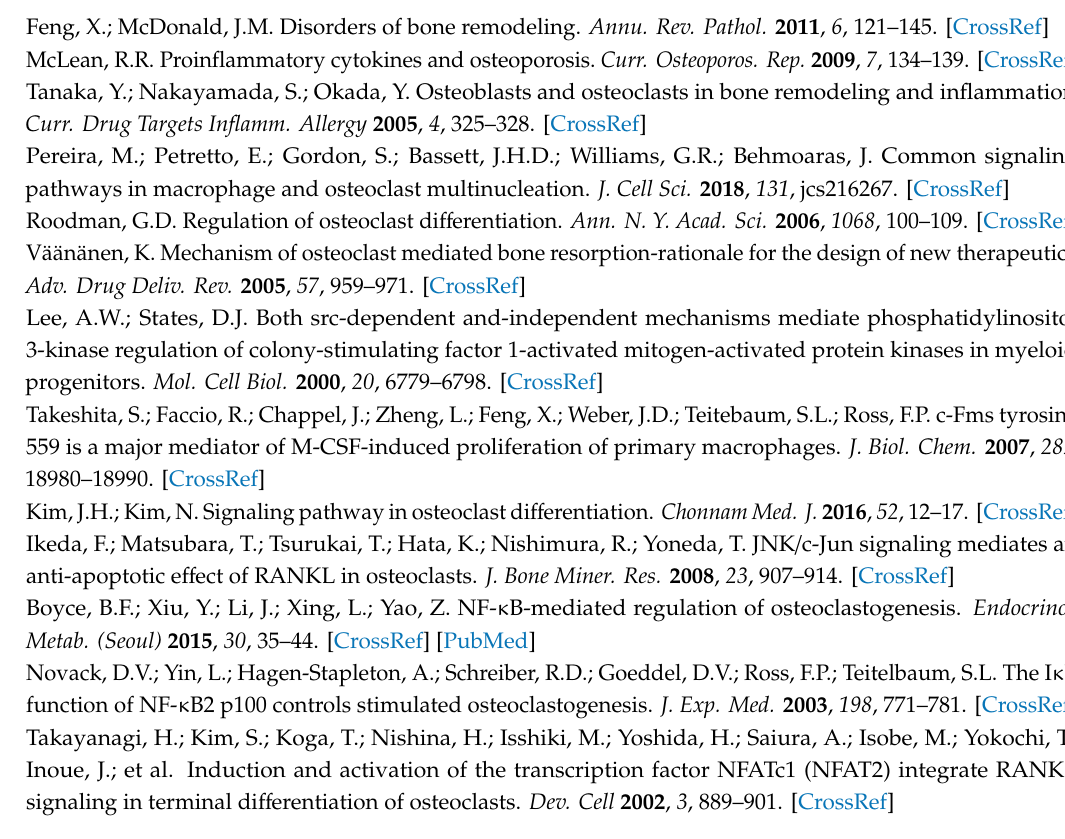
Figure S1: BMMs were cultured for 3 days at the indicated doses of GSPE in the presence of M-CSF (30 ng / mL). Cytotoxicity was determined by XTT assay. Figure S2: The graph indicates the phosphoprotein-to-total protein rations of each molecule in Figure 5A, Figure 5B, and Figure 5C. Figure S3: The graph indicates density of the cleaved-caspase-3, -9, and -8